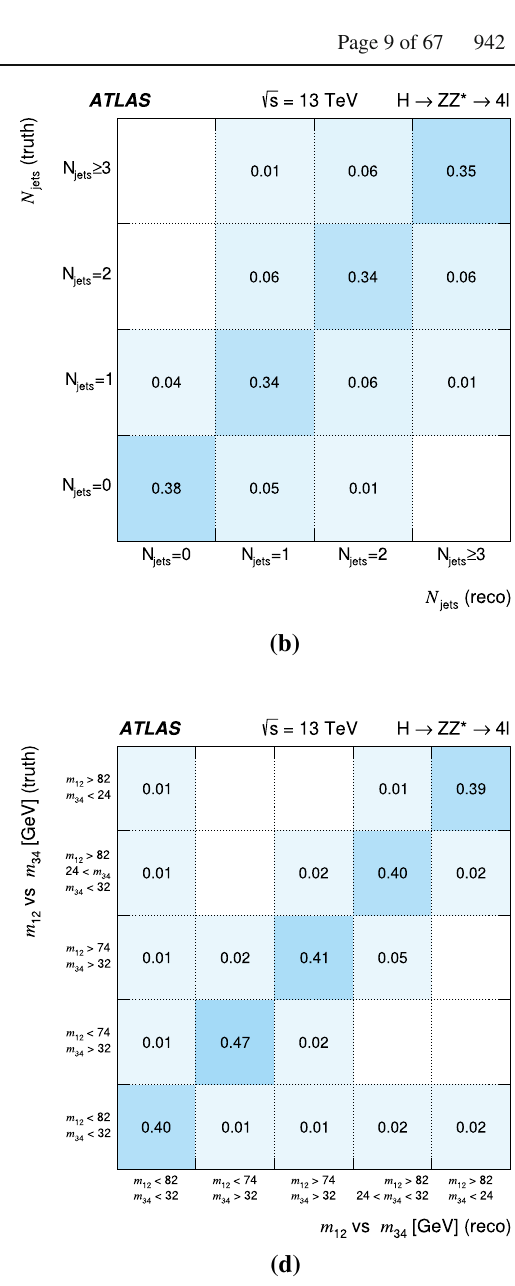
the mass of the leading versus subleading lepton pair m 12 vs . m 34 . Onlyreconstructedeventsthatwerematchedtogenerator-level(‘truth’) , b the number of jets T . jet events are included. Bins below 0.005 are omitted for , and d T